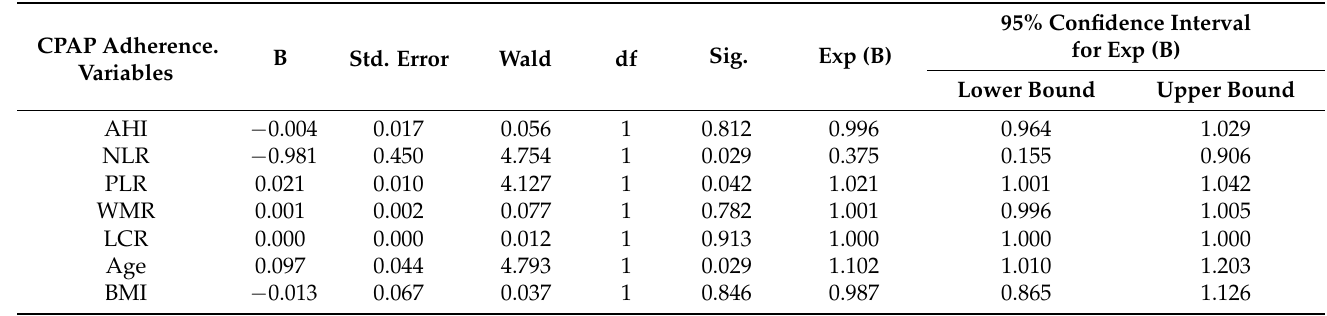
Table 5. Multinominal logistic regression analysis results—patients with moderate and severe OSA ( n =